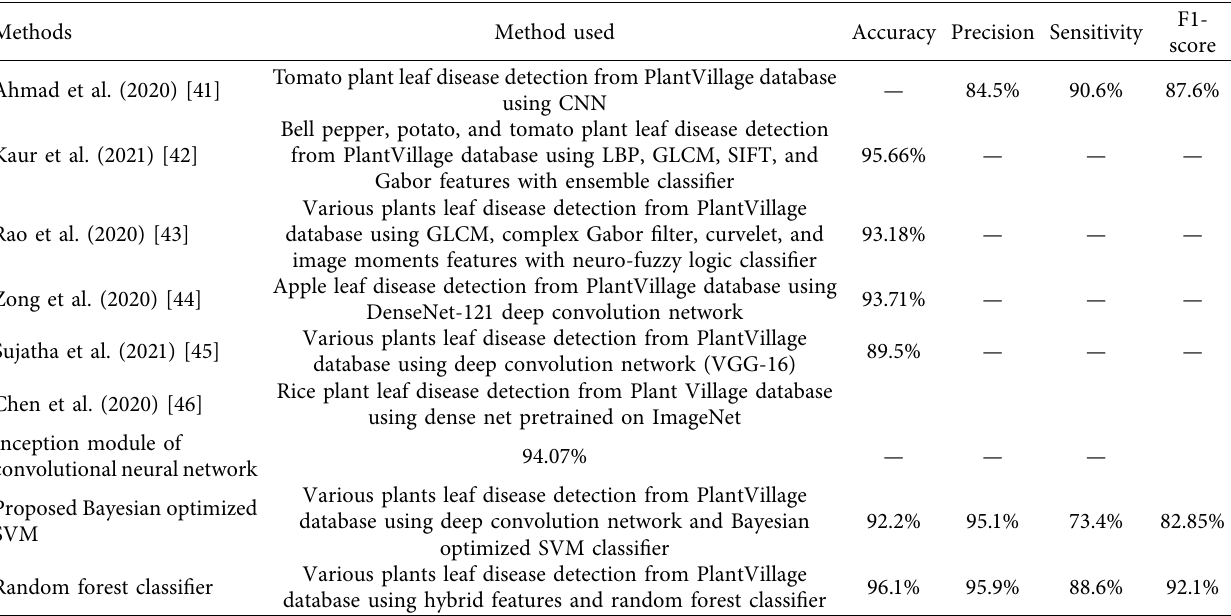
Table 8: Comparative